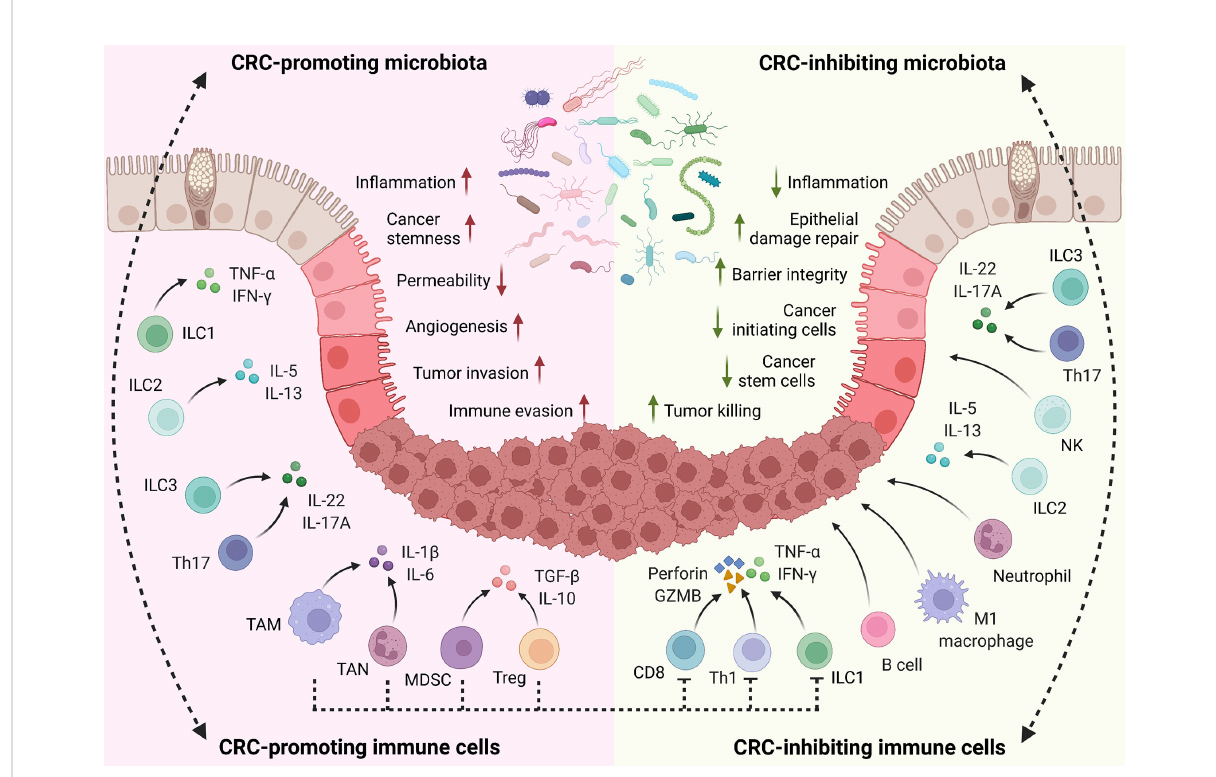
FIGURE 2 Role of host immune system on CRC. In the host intestine, local immune cells are directly or indirectly stimulated by gut microbiota for activation, proliferation, and differentiation. Meanwhile, the microbiota composition is exquisitely modulated by the immune system. This interplay is important for maintaining homeostasis and plays critical roles in regulating in fl ammation responses, tissue damage, and CRC development. Through cytokine production and other mechanisms, CRC-promoting immune cells facilitate in fl ammation, tissue damage, cell proliferation, angiogenesis, tumor invasion, and immune evasion. On the contrary, CRC-inhibiting immune cells enhance epithelial barrier integrity, suppress local in fl ammation, and eliminate cancer-initiating cells and developed tumors through cytokines, cytotoxic molecules, and other mechanisms. Notably, some immune populations play context-dependent functions in CRC development, based on the disease types, stages, and